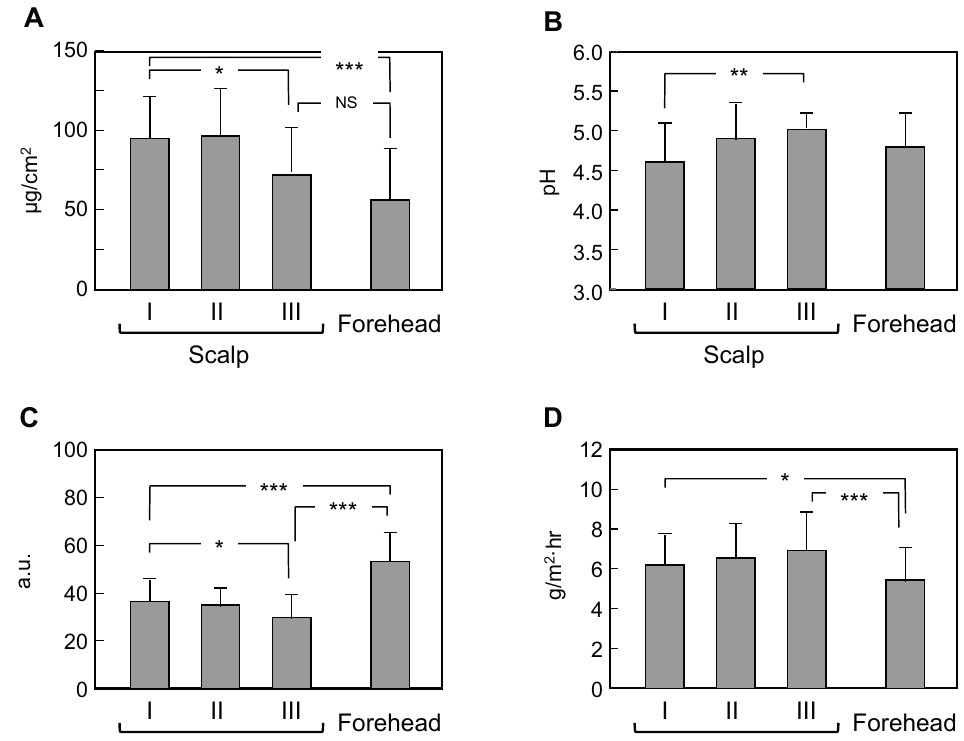
Figure 3. Comparison of measured data for sebum level ( A ), skin surface pH ( B ), MRA ( C ), and TEWL ( D ) between scalps with skin symptoms of different severity and the forehead. Each column indicates the average and the bars show standard deviation. * indicates p < 0.05, ** indicates p < 0.01 and *** indicates p < 0.001 as a significant difference. NS indicates as no significant difference.